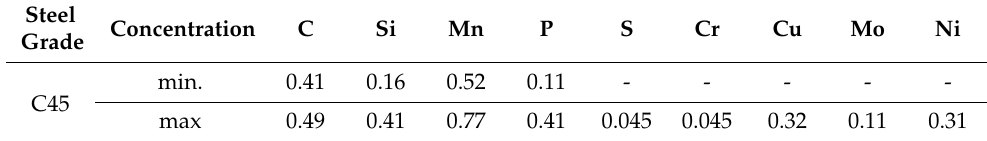
Table 1. Chemical composition of C45 steel [%].